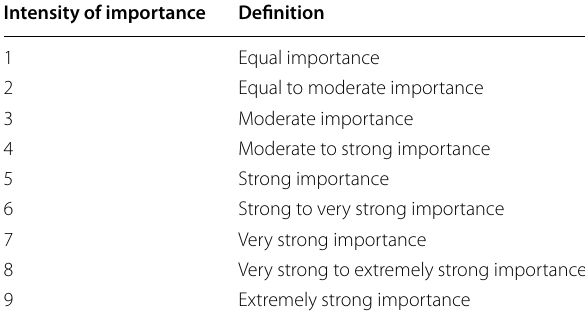
Table 1 Saaty’s scale of importance (Saaty 1980) Intensity of